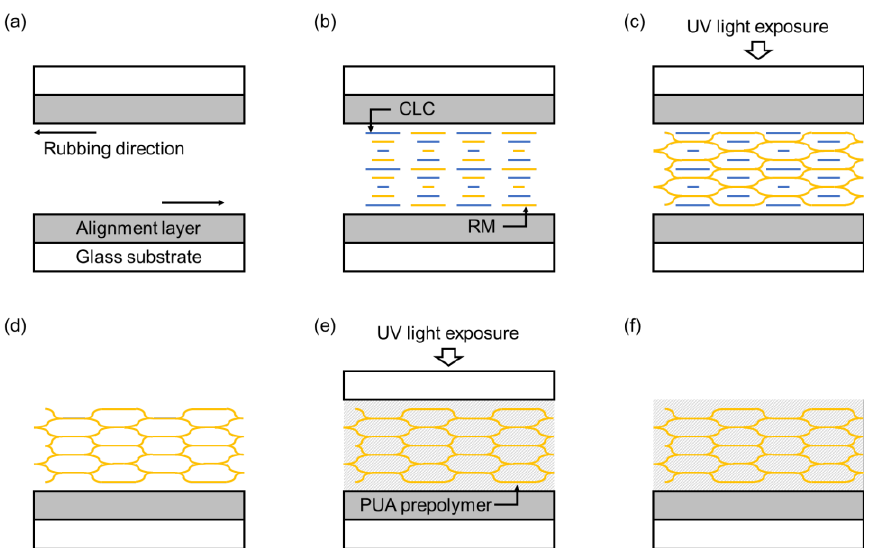
Figure 2. Schematic diagram showing the fabrication process of the CLC-PUA composite film. ( a